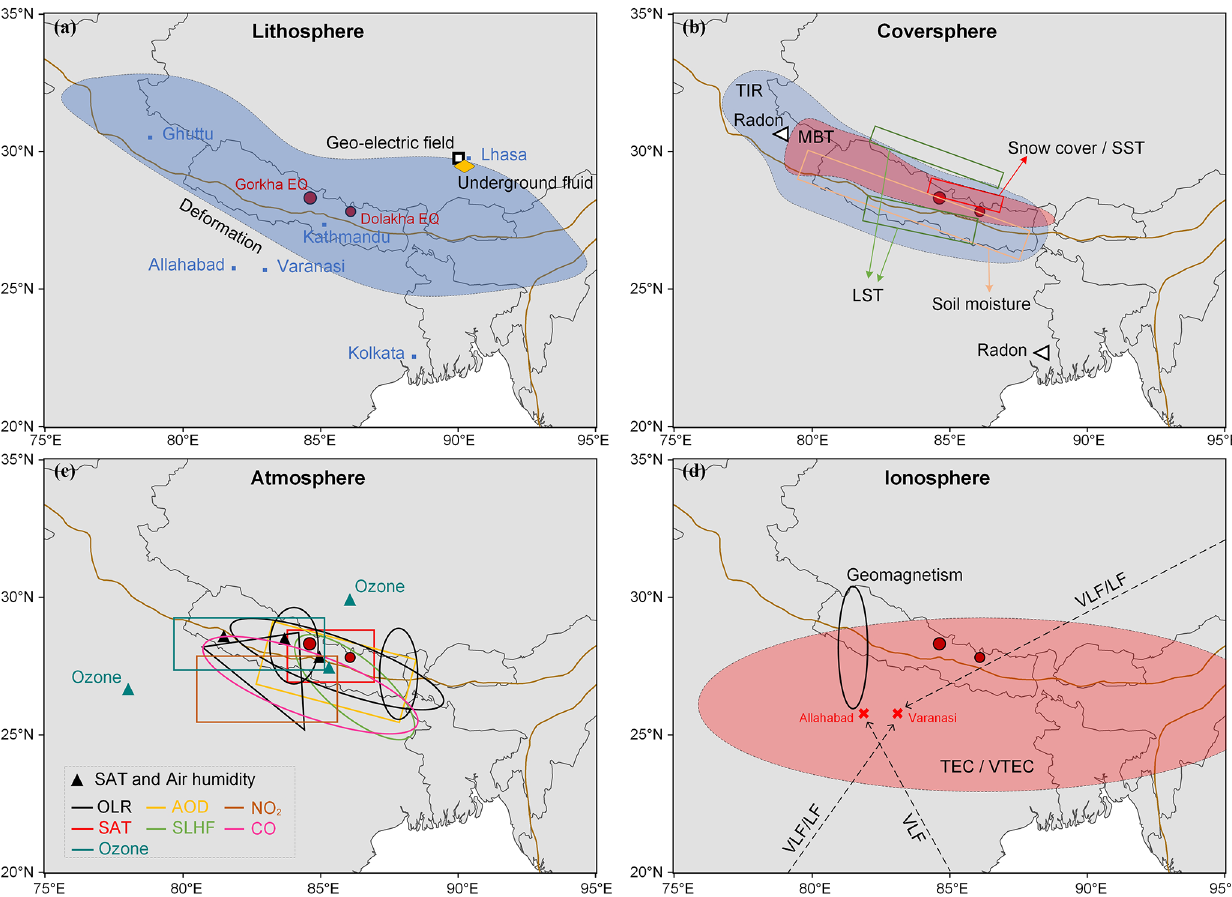
Figure 4. The spatial distribution of multiple anomalies in four geospheres before, during, and after the Gorkha earthquake and Dolakha earthquake in 2015. The geographical locations of the stations were marked for the anomalies recorded by the ground station, and the areas of significant anomalies with detailed descriptions were marked for the anomalies observed by satellites. In Fig. 4a, the blue area only represents the long-term and large-scale deformation area, not the short-term deformation anomaly. In Fig. 4d, the red area represents the northern part of the conjugate ionospheric